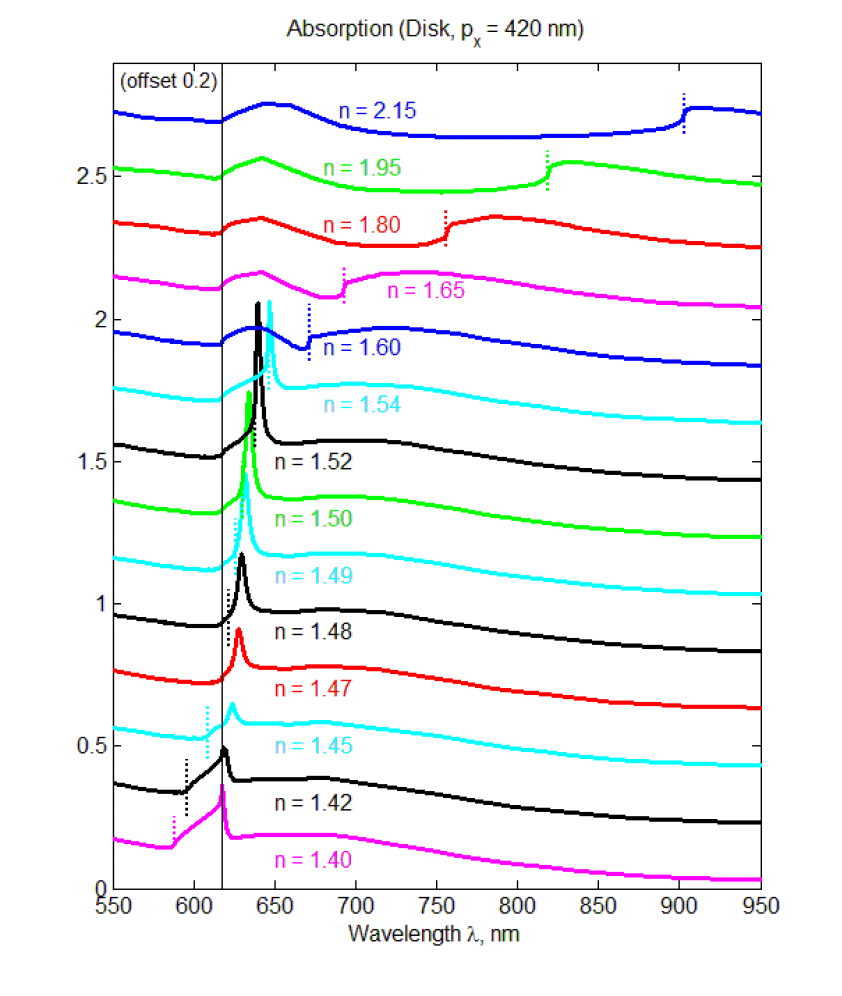
Figure 4. Absorption in a gold nanoparticle array facilitated by the lattice resonance for various refractive indices of the substrate n . Periods are p x = 420 nm and p y = 250 nm, a disk with the radius R d = 85 nm and height H = 50 nm, and the refractive index of the superstrate is n s = 1.47. The dotted color lines denote a wavelength of Rayleigh anomaly, that is, where the resonances in the substrate are expected, i.e., λ RA = np x , and the solid black line corresponds to the resonance in the superstrate, i.e., λ RAs = n s p x . Light incidence is normal to the substrate, and electric field E is along the x -axis. For clarity, each absorption spectrum is vertically shifted by 0.2. Reproduced with permission from [69]. Copyright 2018 American Chemical